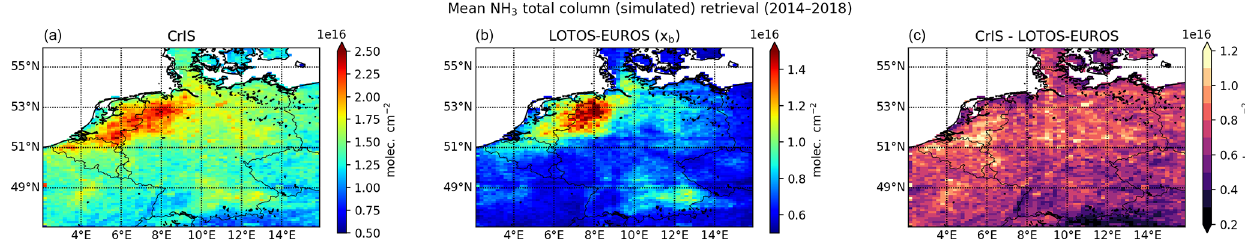
Figure 2. Mean retrieved (a) and simulated (b) NH 3 total column from 2014–2018, as well as their absolute difference (c)